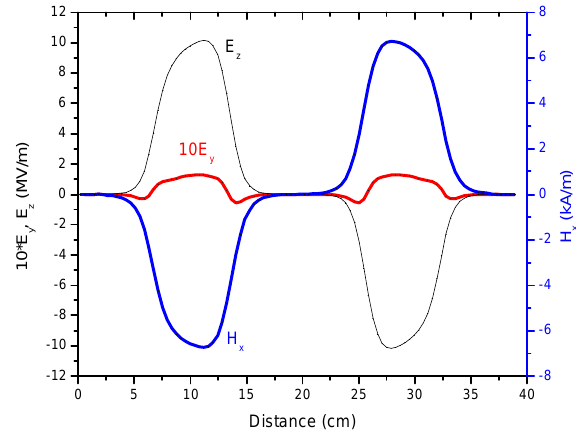
FIG. 2. (Color) Field distribution along the axis of the 115 MHz QWR. For clarity, the magnetic field is shown with opposite sign with respect to the electric field. The amplitude of E y is multiplied by a factor of